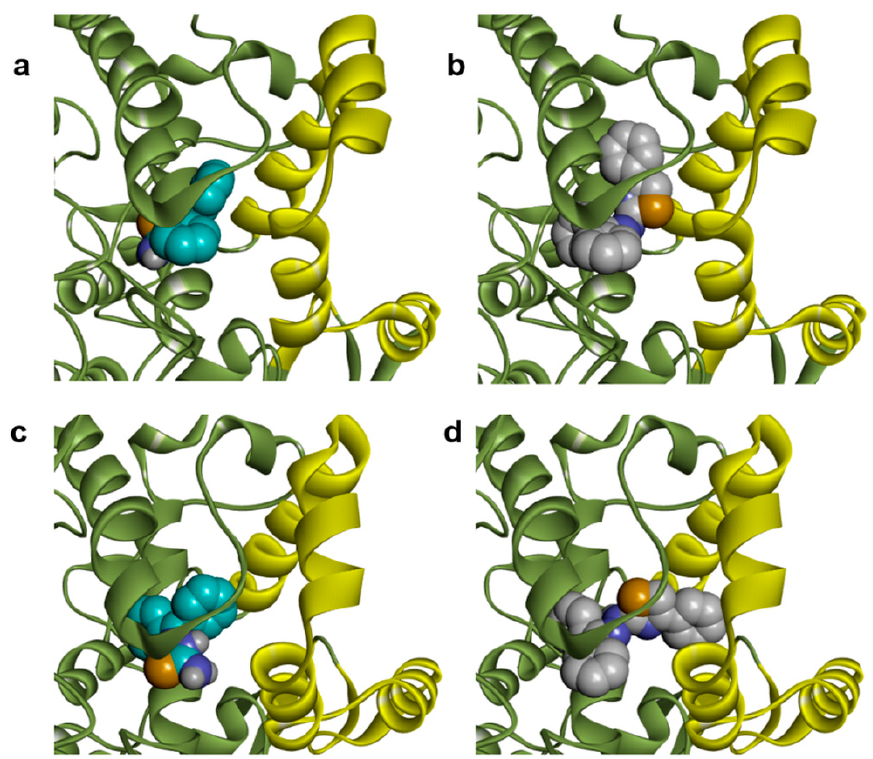
Figure 7. Conformations of 2a (cyan carbons, yellow sulfur, blue nitrogen) and 3a (white carbons) into COX isoenzymes active sites, highlighting their position relative to the catalytic (green ribbon) and the membrane binding domain (yellow ribbon). ( a ) Pose of 2a into COX-1 (PDB ID: 2OYU) active site; ( b ) Pose of 3a into COX-1 (PDB ID: 2OYU) active site; ( c ) Pose of 2a into COX-2 (PDB ID: 3NT1) active site; ( d ) Pose of 3a into COX-2 (PDB ID: 3NT1) active site.